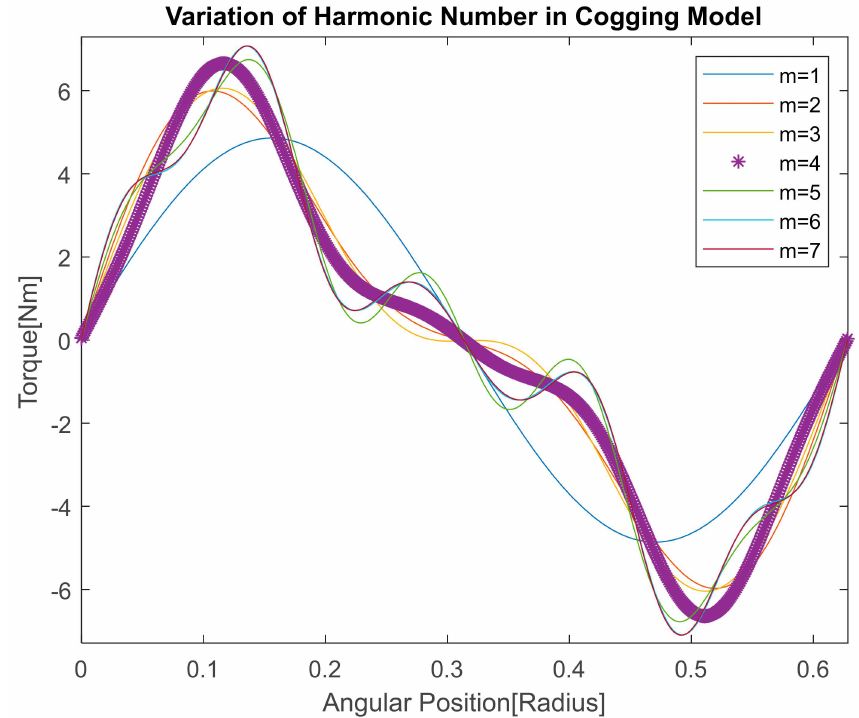
Figure 2. Comparison of the mathematical model of cogging torque with variation of the number of harmonics. The symbol * refers to the purple curve (m = 4) selected as the best trade-o ff between model accuracy and complexity.